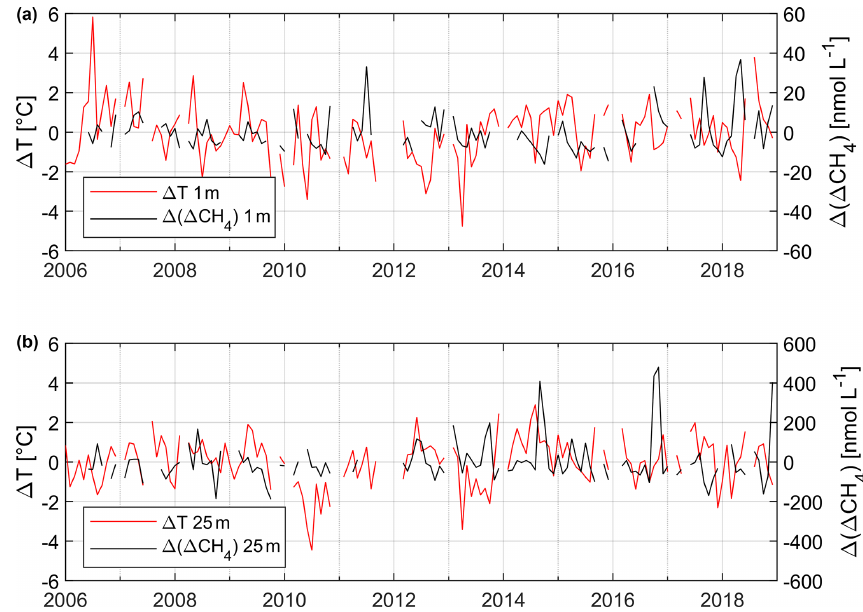
Figure 10. Monthly anomalies of temperature ( (cid:49)T , solid red line, left y axis) and (cid:49) CH 4 ( (cid:49) ( (cid:49) CH 4 ), solid black line, right y axis) at 1 (a) and 25m (b) from 2006 to 2019. Please note that gaps in the data sets are caused by missing